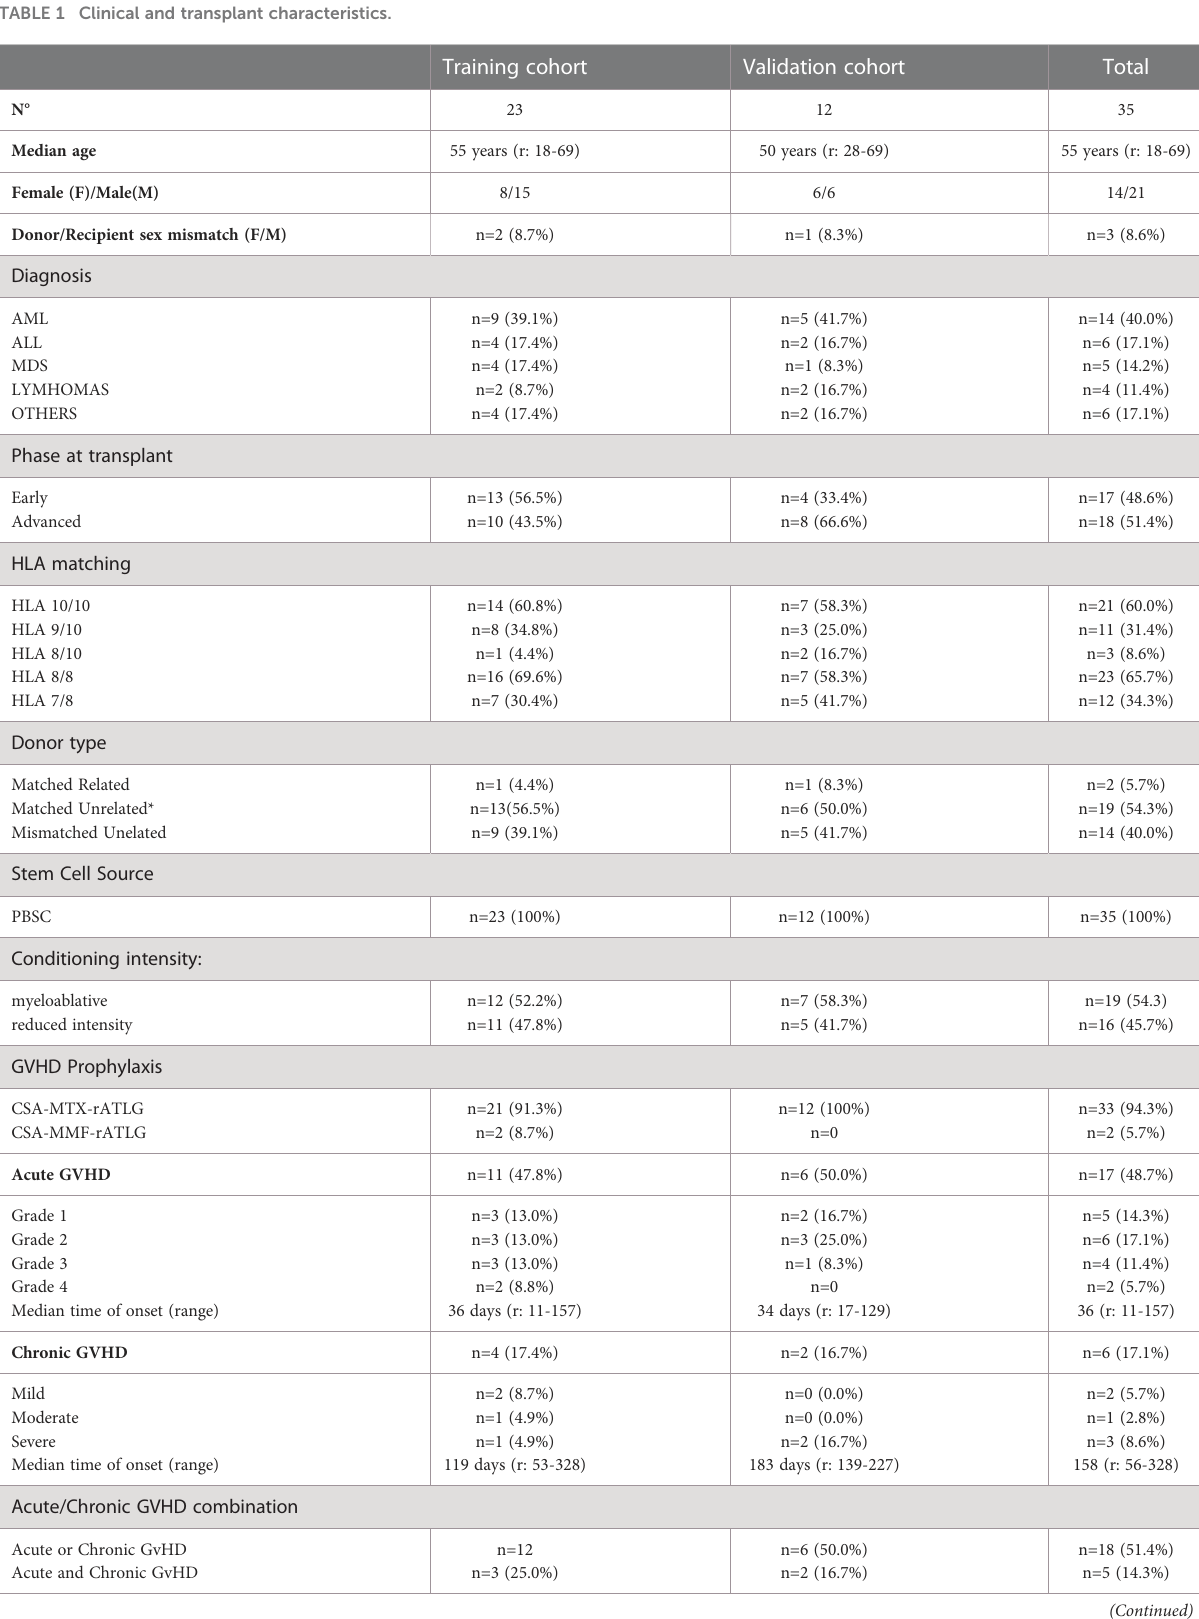
TABLE 1 Clinical and transplant